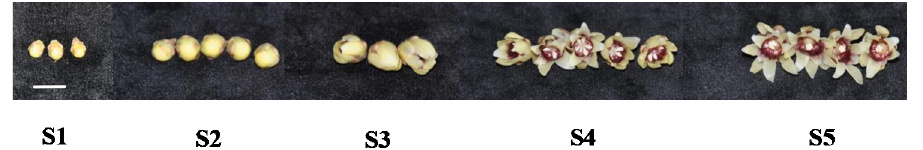
Figure 6. Flower development stages in wintersweet. S1 : Closed bud with green petals, S2 : Closed bud with yellow petals, S3 : Partial open flower, S4 : Open flower but not pollinated, S5 : Senescent flower. Scale bar = 1 cm.